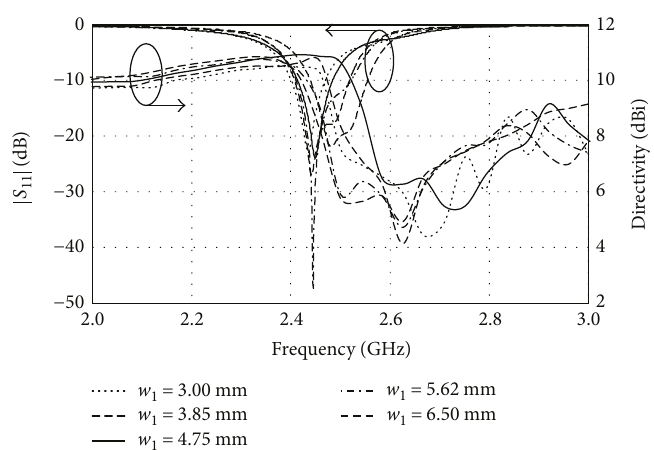
Figure 10: The simulated antenna directivity and | S